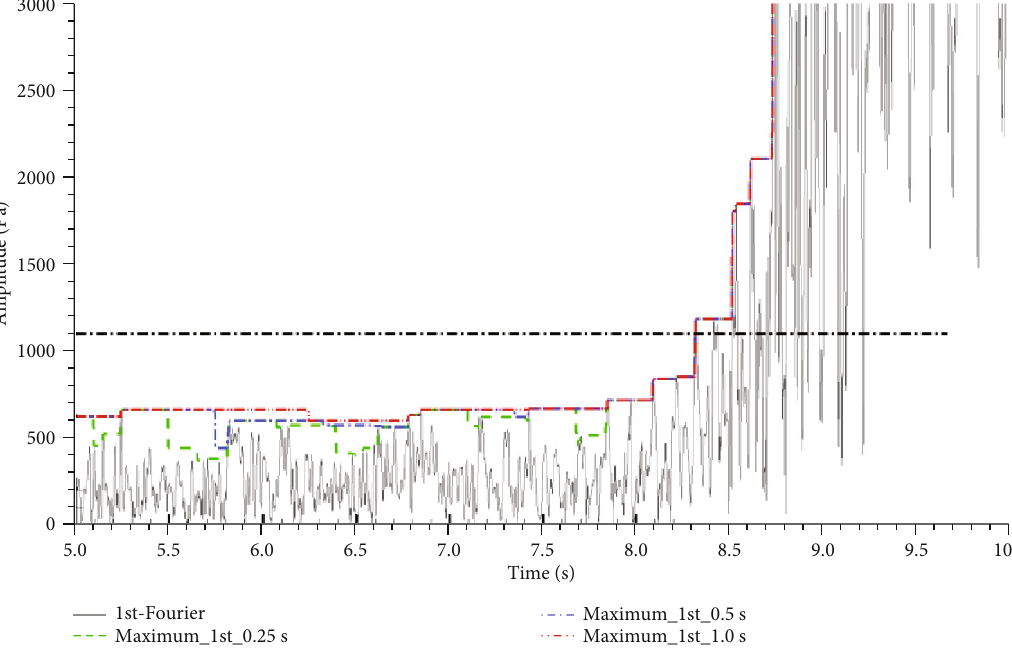
Figure 9: The maximum amplitude of the fi rst-order harmonic of the total pressure during the stall inception.